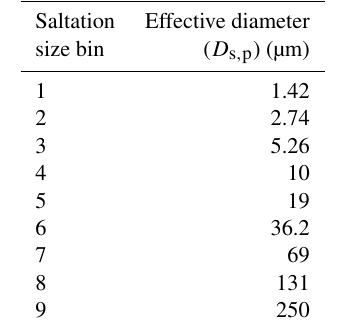
Table 1. Saltation particle size bins and their associated effective diameters (adapted from LeGrand et al., 2019, Table 1). Particle diameters are presented here in micrometers but handled in units of centimeters within the